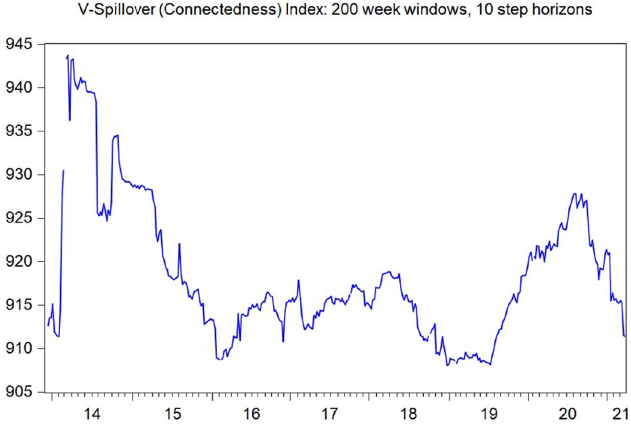
Fig 6. Volatility spillover index plotting, estimated using the DY spillover index method for all ten financial markets. The figure plot moving volatility spillover indexes, defined as the sum of all variance decomposition “contributions to others”, estimated using a 200-week rolling window.